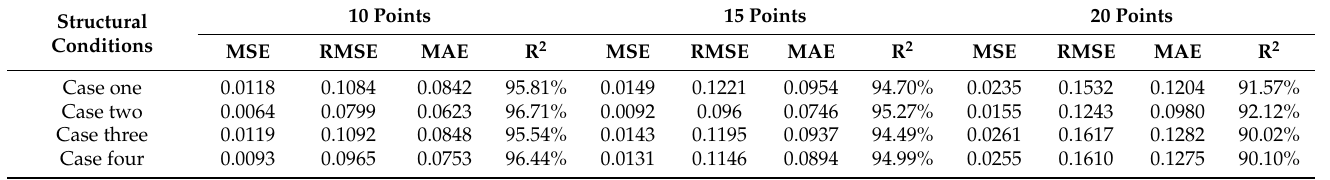
Table 5. Predicted results of the three-story building structure using the EMD-BiGRU algorithm. 10 Points 15 Points 20 Structural Conditions